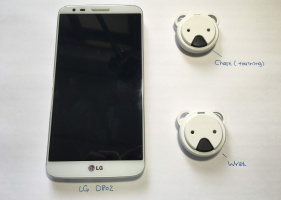
Figure 9. Required hardware in the sleep posture monitoring system. On the left is an Android smartphone, on the right are two wearable